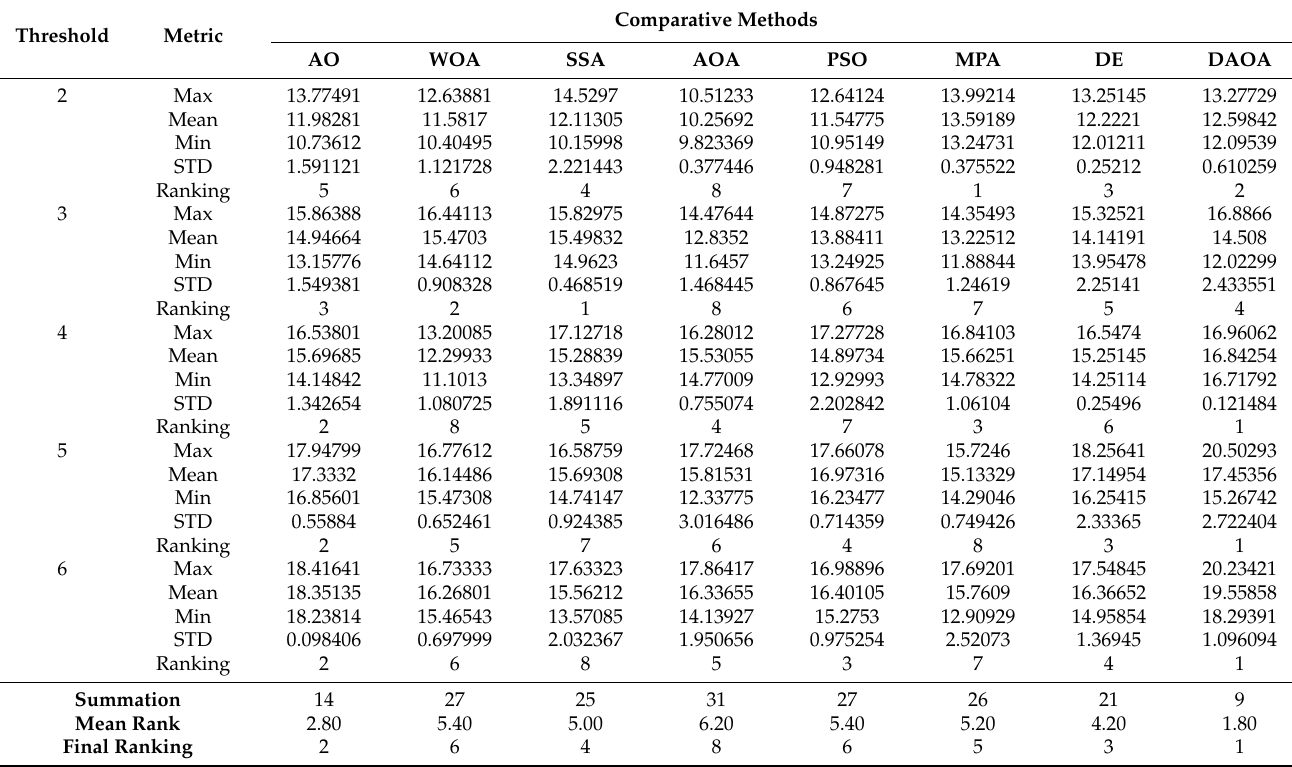
Table 4. The PSNR results of the test case